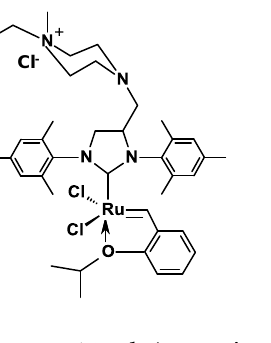
Figure 2. Typical Grubbs-, and Hoveyda–Grubbs-type carbenes used in hybrid